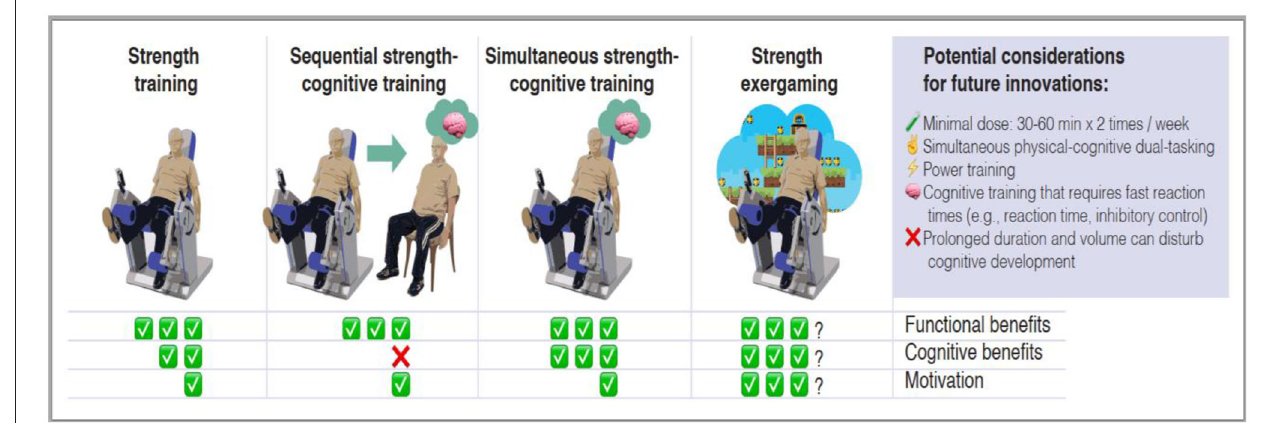
FIGURE 2 | A suggested conceptual research framework for developing strength-cognitive exergames to increase strength training adherence and motivation in adults and the older adults.